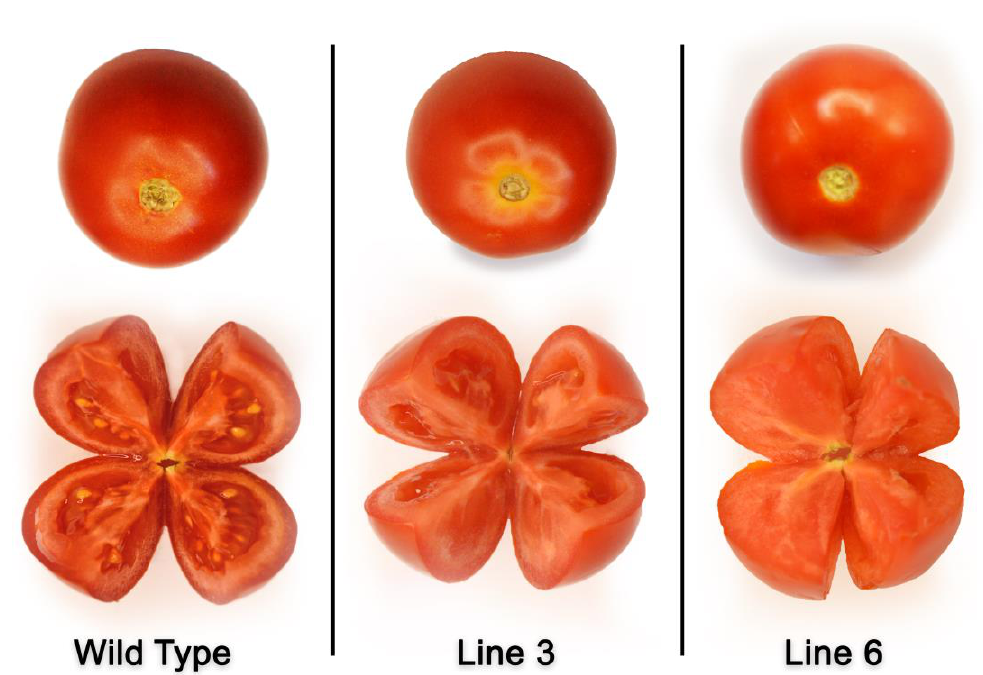
Figure 5. Harvested fruits and seeds formed in ripe fruits of WT and SlACO2 mutant plants.